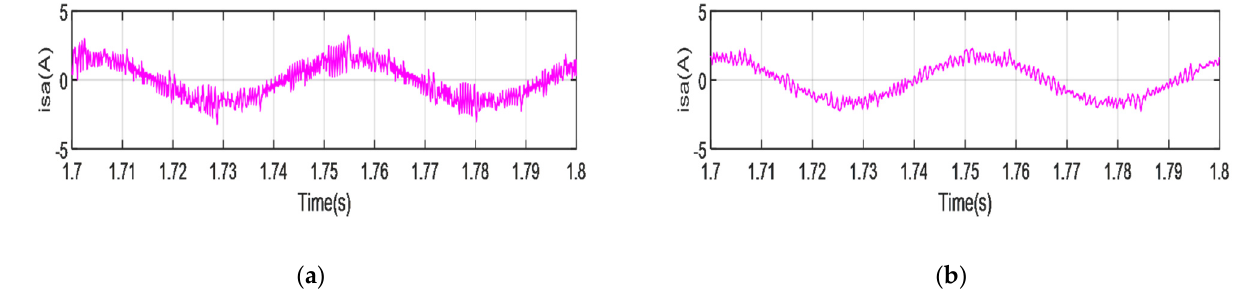
Figure 21. Stator current: ( a ) conventional inverter; ( b ) five-level inverter.